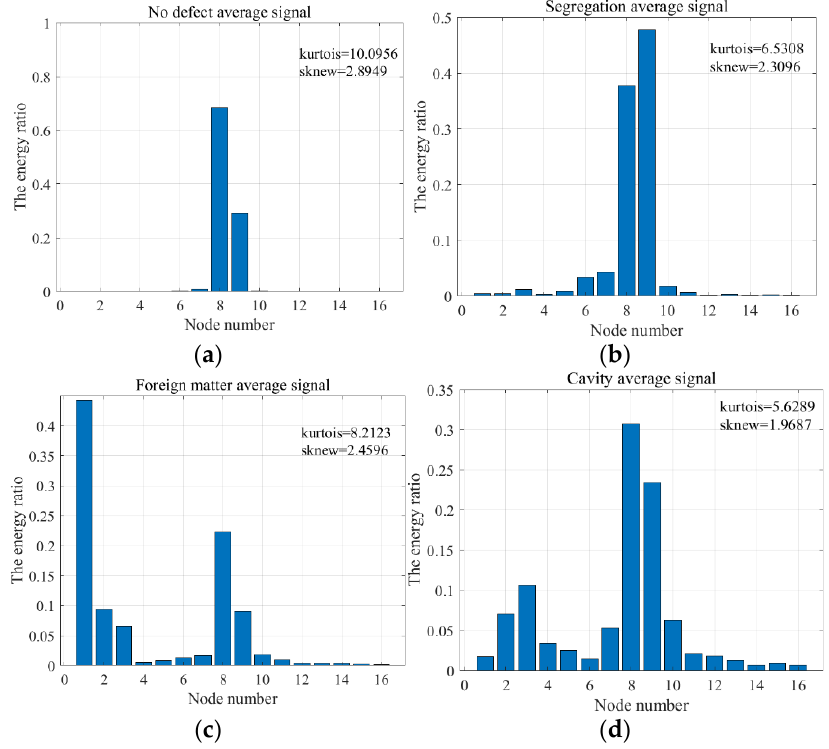
Figure 7. ( a ) Wavelet packet energy ratio of no defect average signal; ( b ) Wavelet packet energy ratio of segregation average signal; ( c ) Wavelet packet energy ratio of foreign matter average signal; ( d ) Wavelet packet energy ratio of cavity average signal.